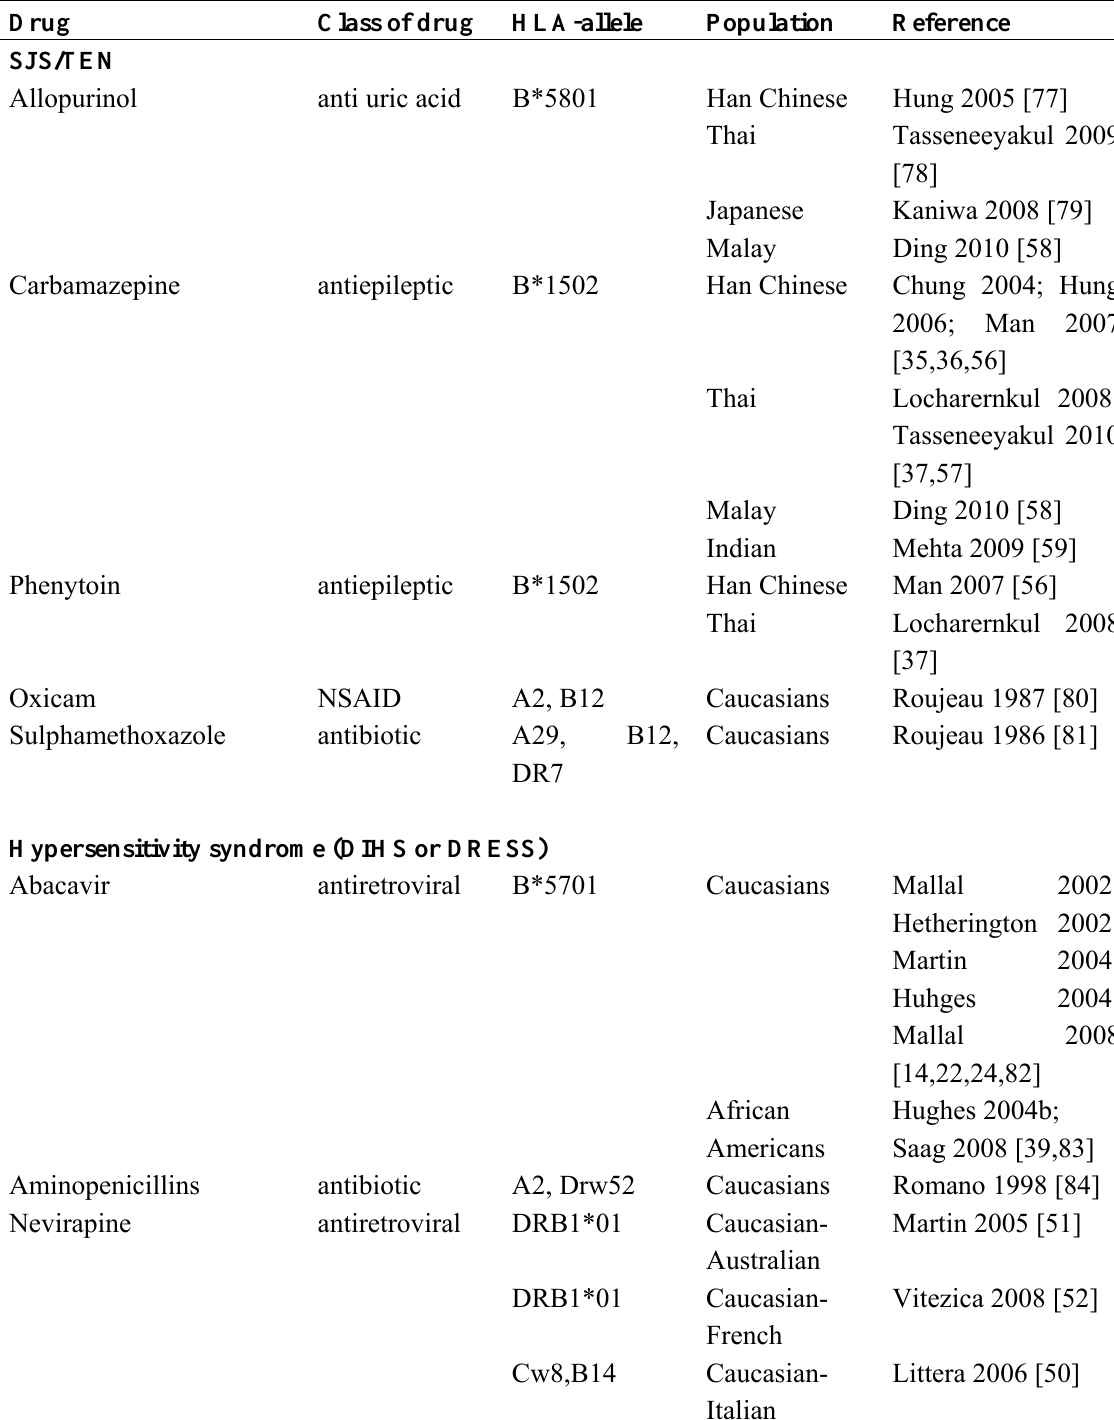
Table 3 . An overview of HLA allele associations with drug-induced hypersensitivity in different